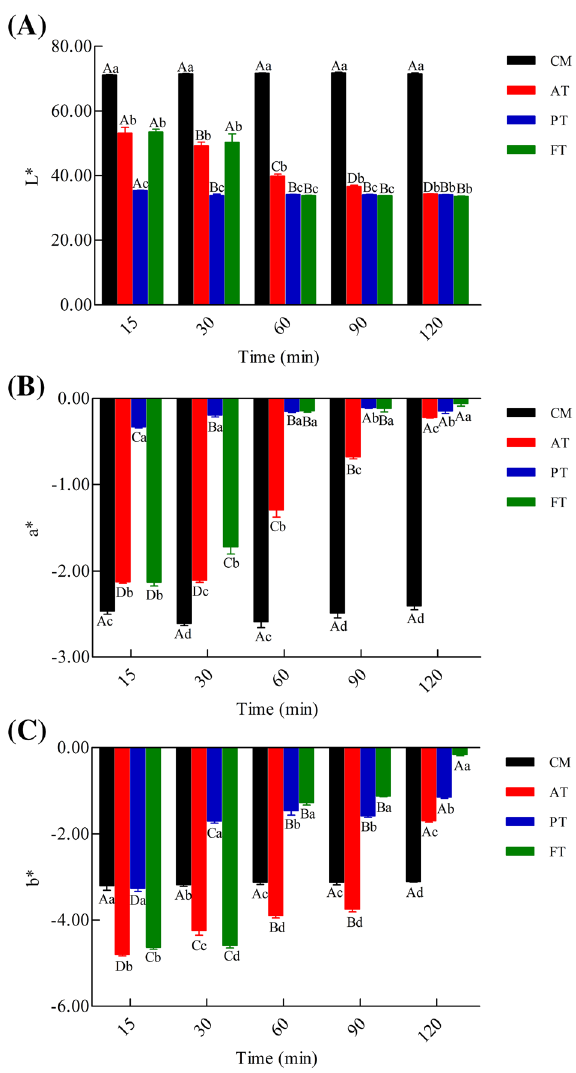
Figure 11. Color measurement L* ( A ), a* ( B ), b*( C ) of CM, AT, PT and FT. Alcalase-treated cow milk (AT), Protamex-treated cow milk (PT), Flavourzyme-treated cow milk